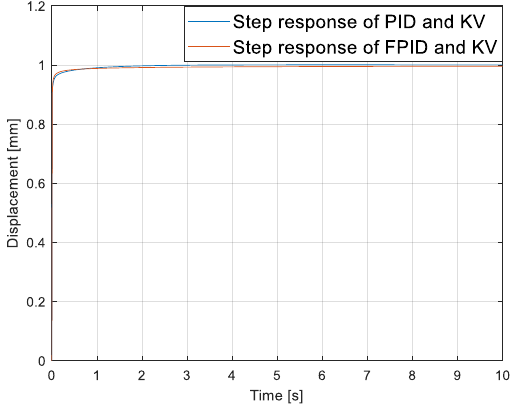
Figure 5. Step response of plant model with the PID and 𝑃𝐼 λ 𝐷 𝜇 controller.